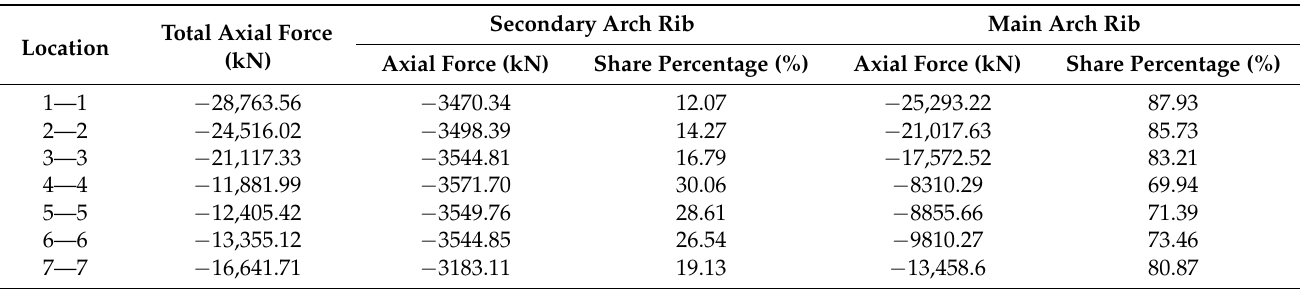
Table 7. Axial force sharing percentages of main arch rib and secondary arch rib.